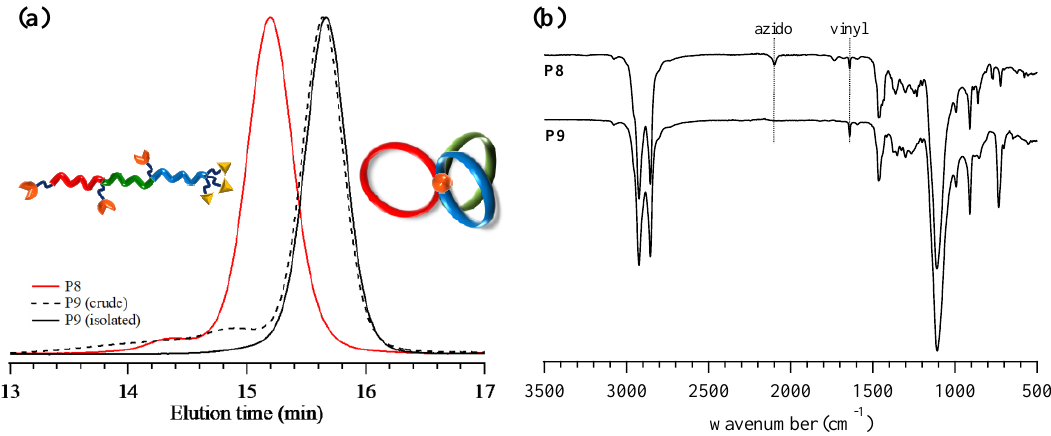
Figure 4. ( a ) SEC traces of P8 (red line) and P9 (dotted line, before purification; solid line, after purification using preparative SEC). ( b ) FT-IR spectra of P8 (upper) and P9 (lower).